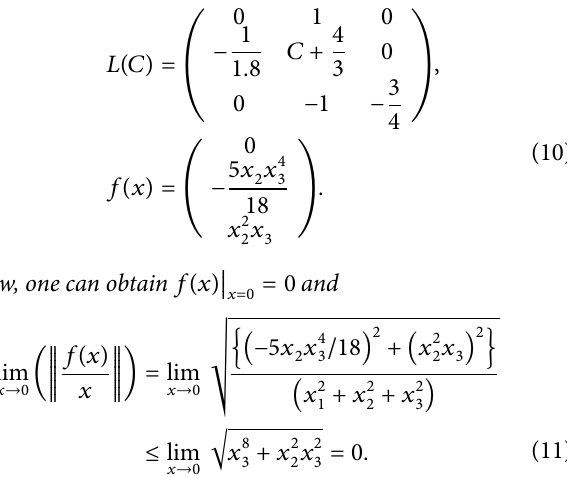
Figure 4) in fractional-order memristive system (2) with initial conditions ( 𝑥 10 , 𝑥 20 , 𝑥 30 ) = (2, 1, 1).